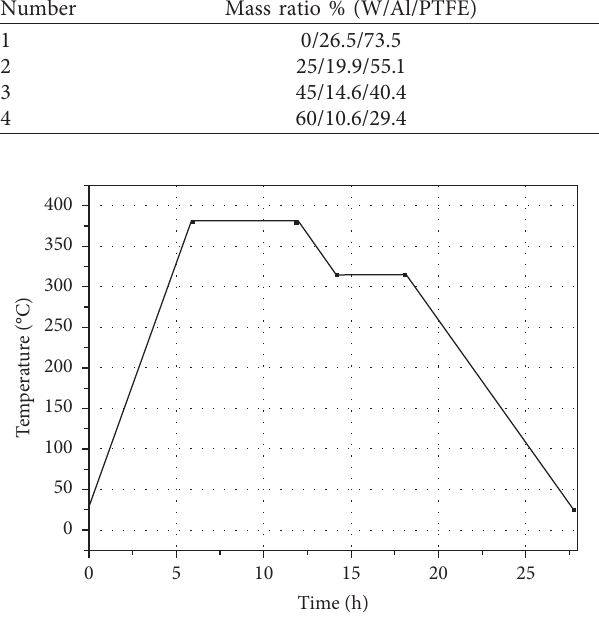
Figure 2: Process used to prepare the Al/PTFE/W composites.